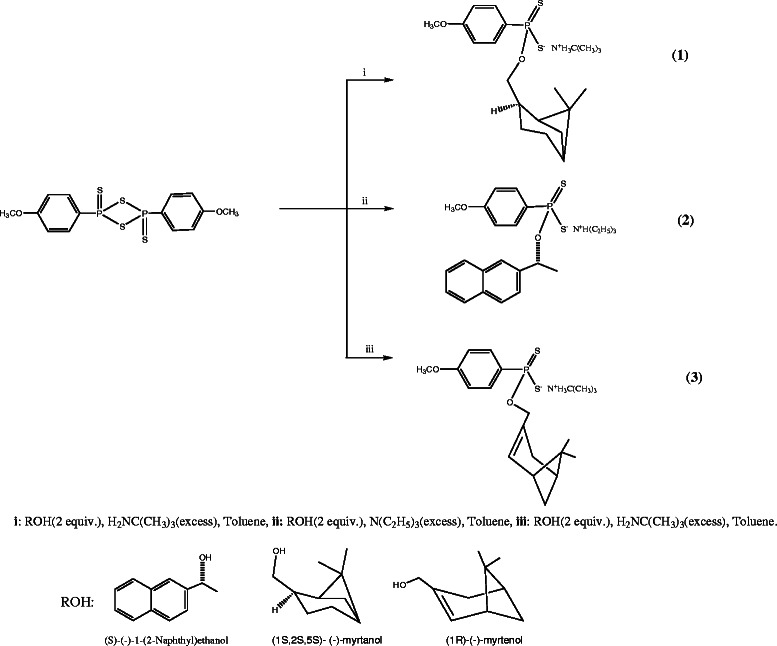
Synthesis of 1-3.